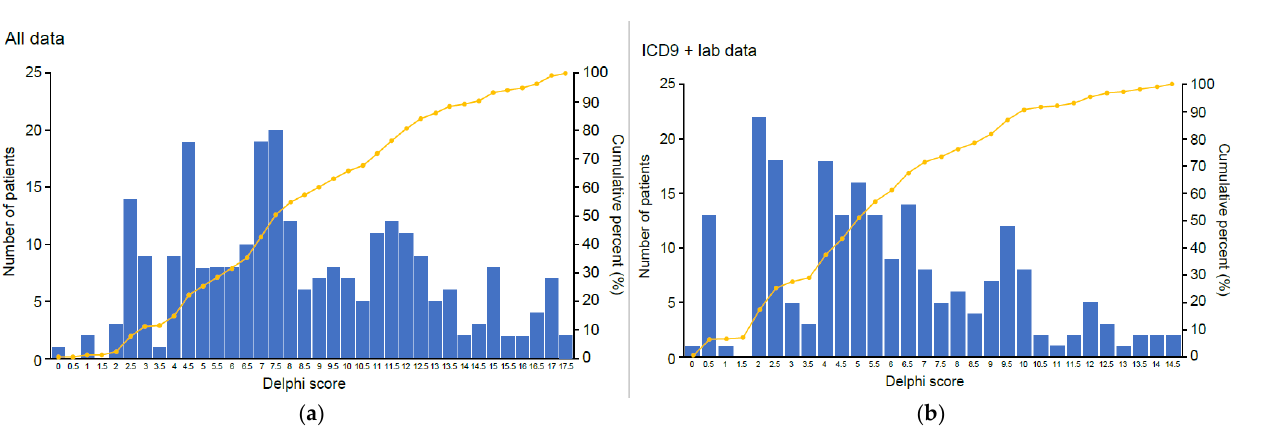
Figure 2. Frequency and cumulative frequency of the GED-C scores of all data sources, and ICD-9 coding plus laboratory data. ( a ) All data; ( b ) ICD9 + lab data. GED-C = Gaucher Earlier Diagnosis Consensus; ICD-9 = International Classification of Diseases, Ninth Revision.